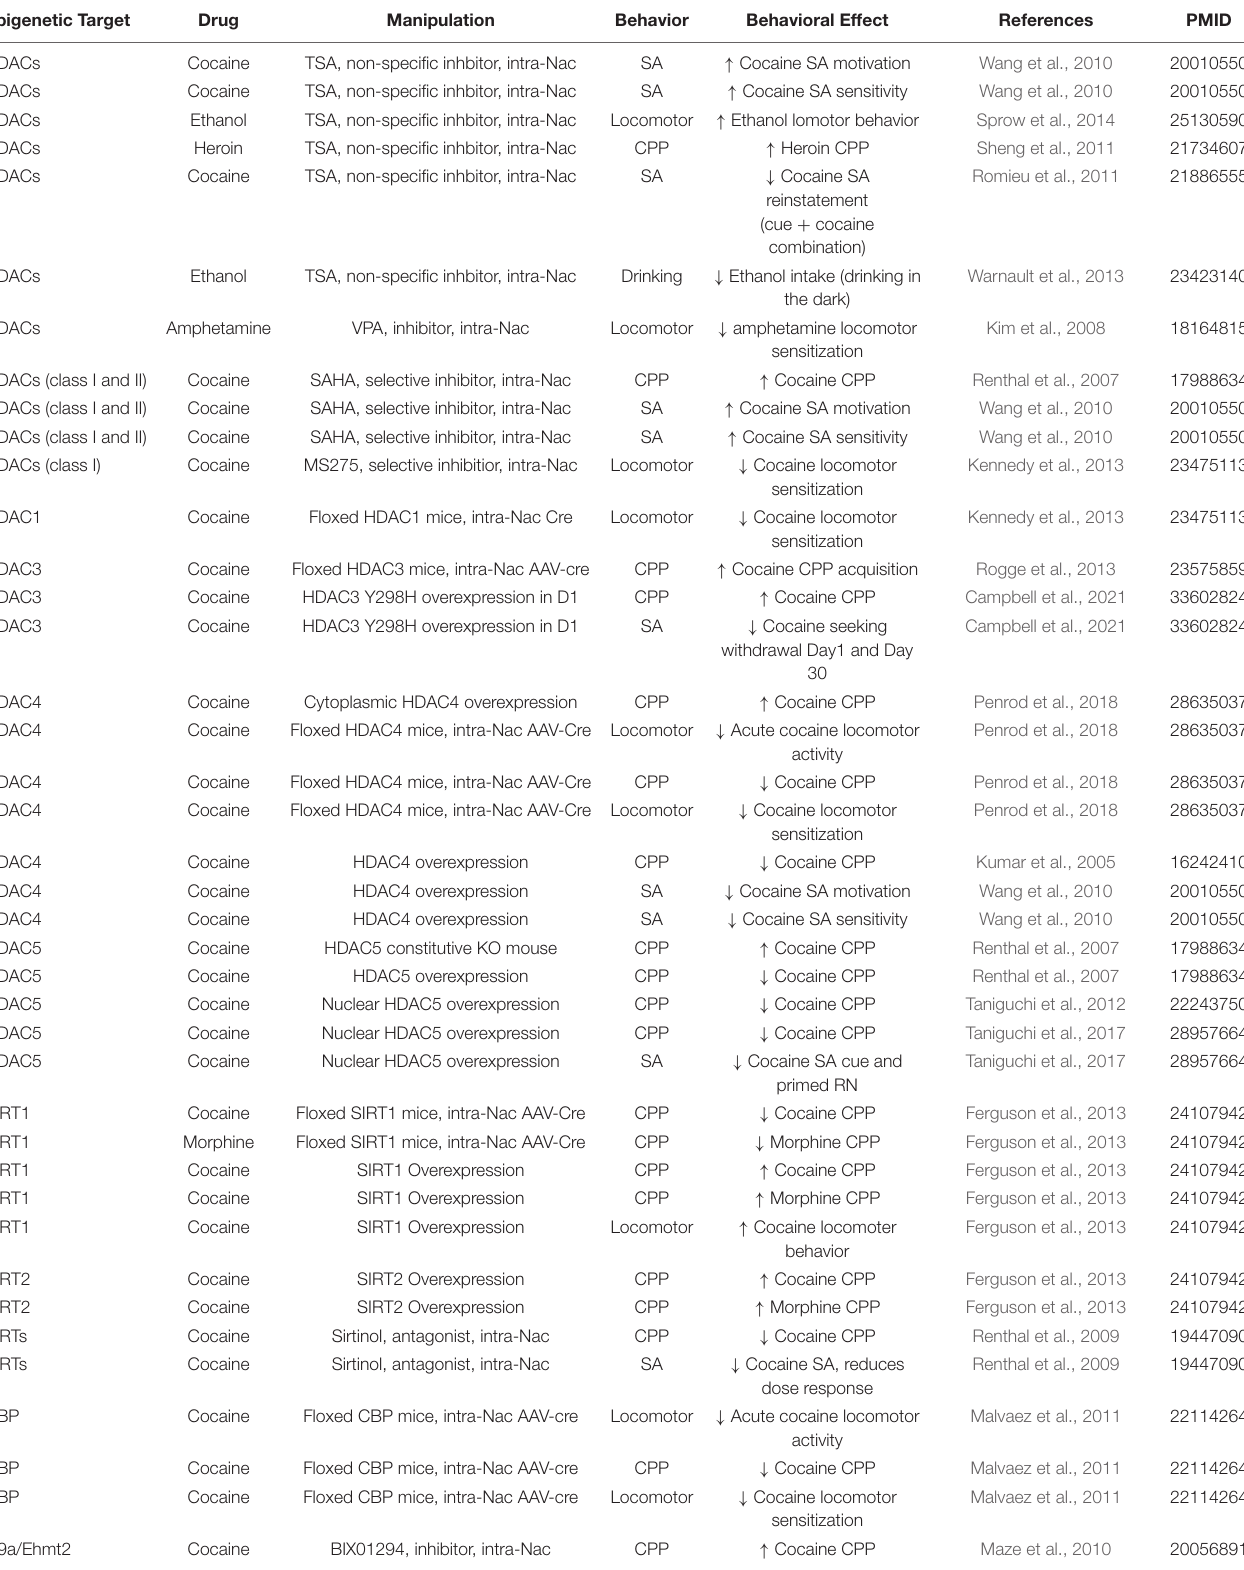
TABLE 5 | Effects of NAc-specific epigenetic regulator manipulations on drug-related behaviors. Epigenetic